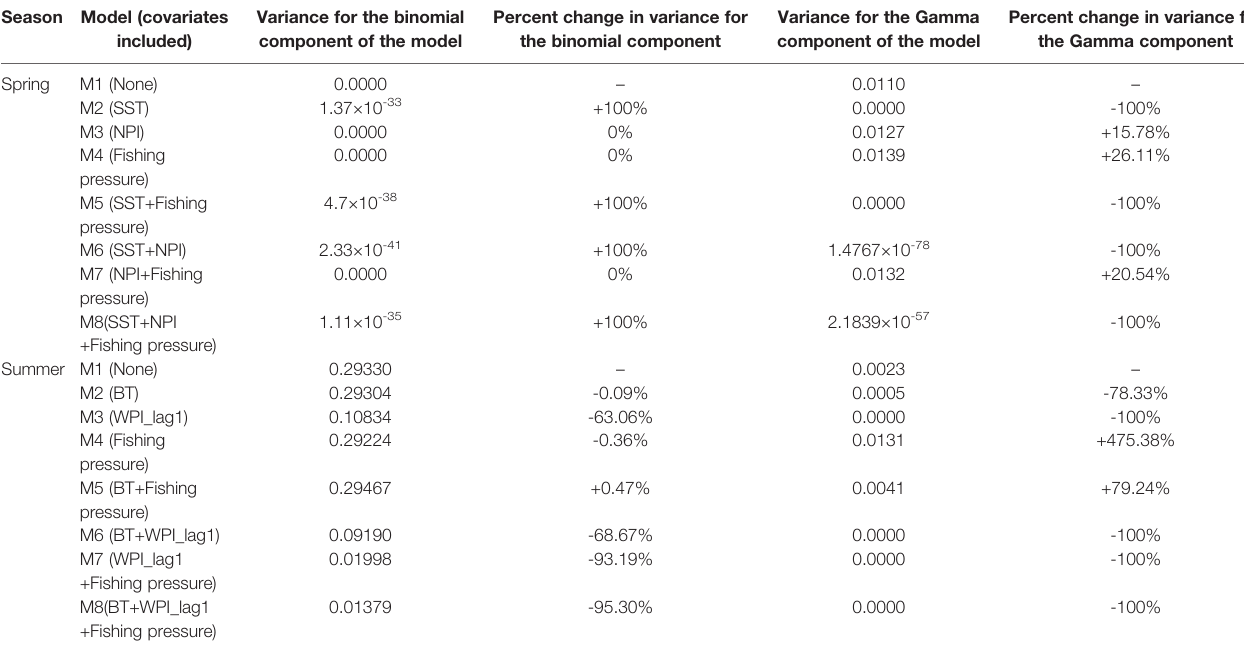
TABLE 1 | The variances of the spatio-temporal variations of encounter probability and non-zero density probability calculated by the eight models developed in spring and summer in the present study (M1-M8). Season Model (covariates Variance for the binomial Percent change in variance for Variance for the Gamma included) component of the model the binomial component component of the